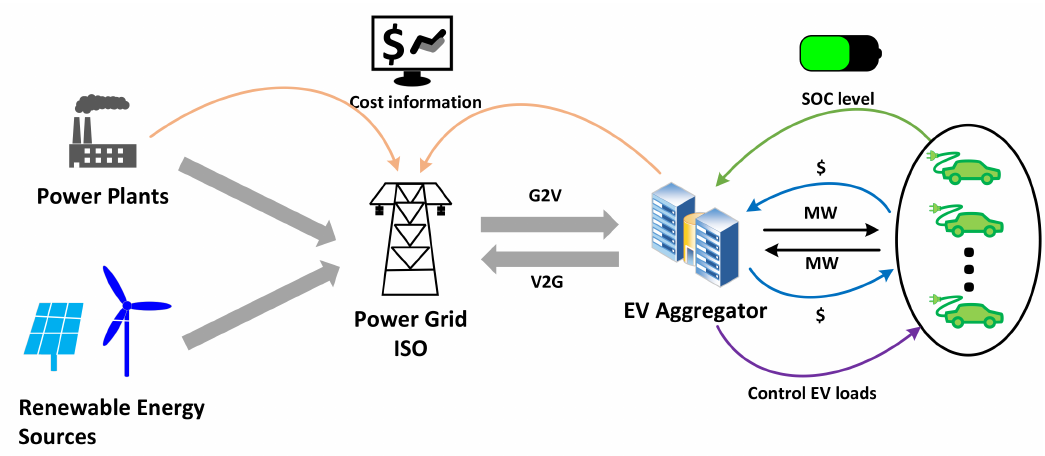
Figure 1. Configuration of the proposed framework. SOC: state-of-charge; G2V: grid-to-vehicle; V2G: vehicle-to-grid; ISO: independent system operator; EV: electric